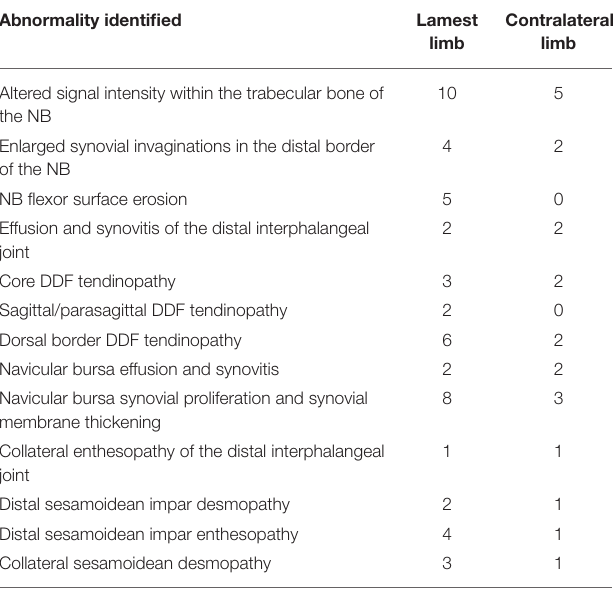
Abnormality identified Lamest